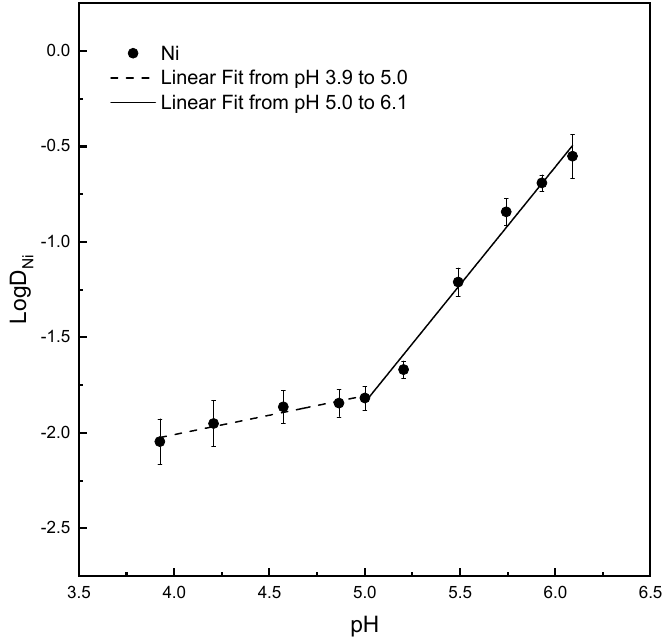
Figure 14. Correlation of extraction equilibrium pH to distribution coefficient of nickel. Experimental conditions were the same as described in Figure 13.